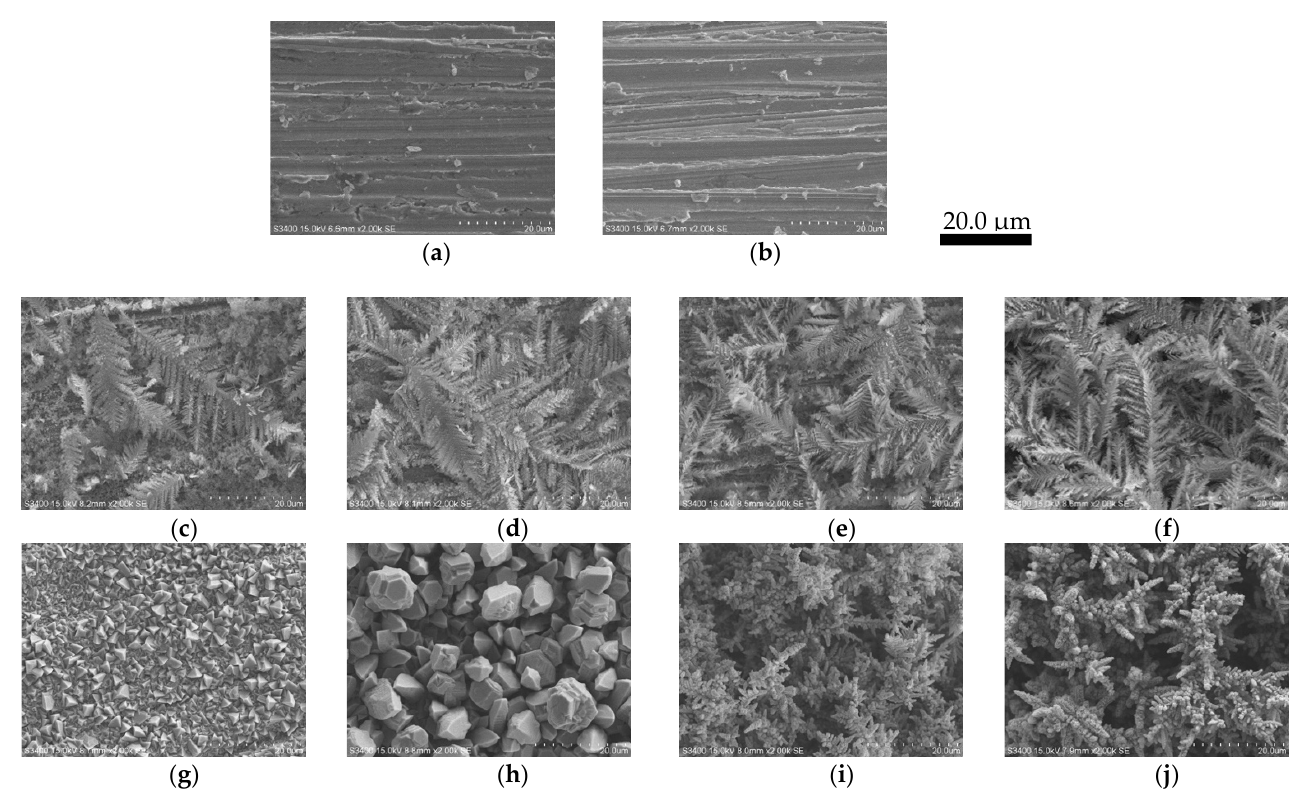
Figure 2. SEM images of ( a ) Zn foil, ( b ) Cu foil, ( c) Zn/Cu–Na60, ( d ) Zn/Cu–Na200, ( e ) ZnCu/Cu–Na60, ( f ) ZnCu/Cu– Na200, ( g ) Zn/Cu–H60, ( h ) Zn/Cu–H200, ( i ) ZnCu/Cu–H60, and ( j ) ZnCu/Cu–H200. Table 1. Percentage by weight of deposited metals on the electrocatalysts.